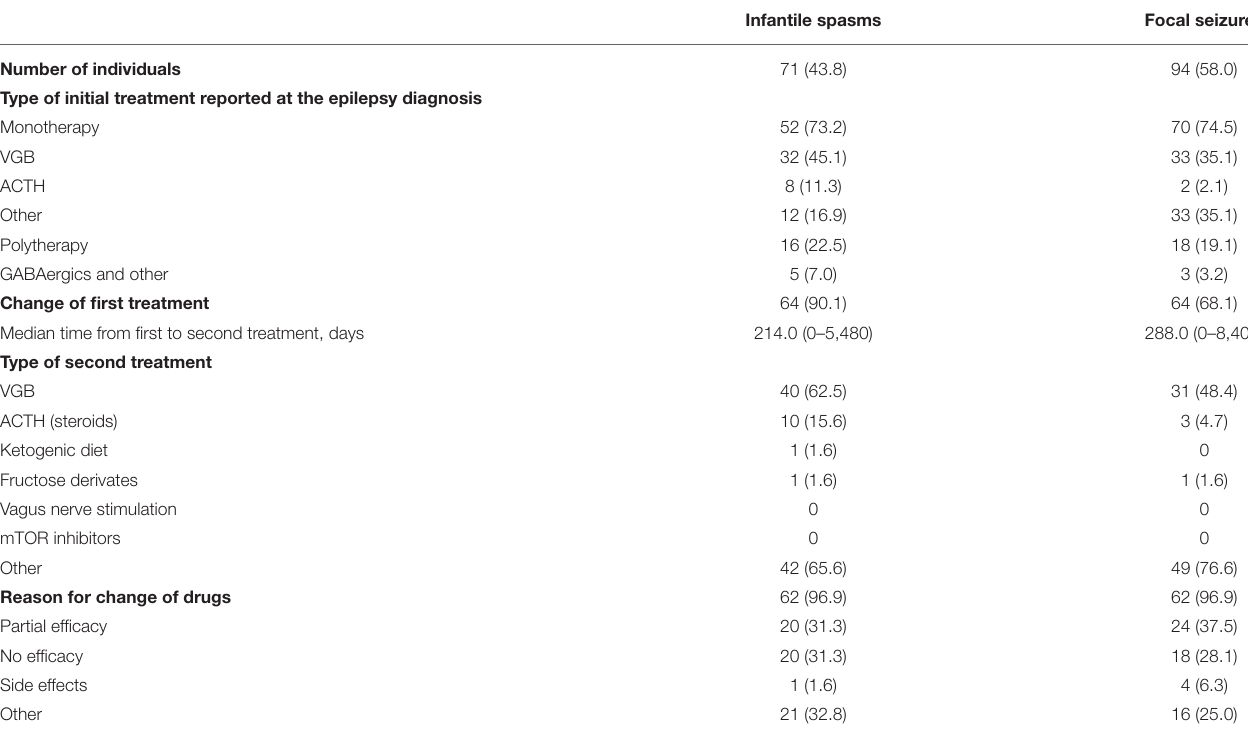
Infantile spasms Focal seizures